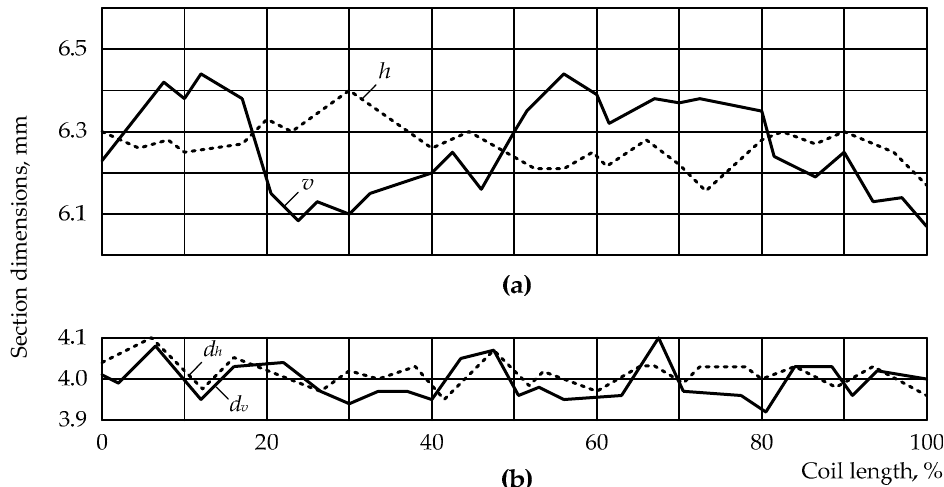
Figure 11. Diagrams of Longitudinal Geometry Variation for the Initial Billet ( a ) and Wire ( b ). Steel U12A.